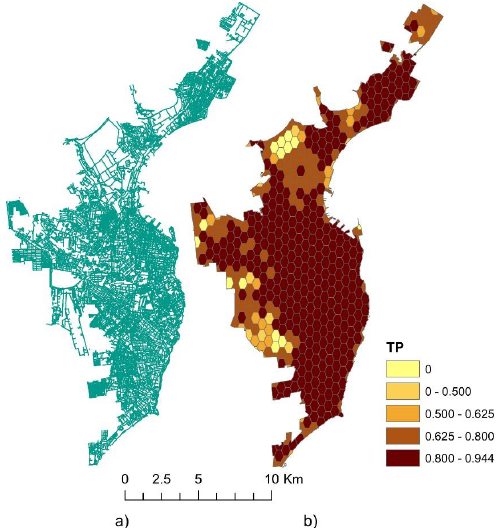
Figure 11. Modeling results for the territory of the city of Odessa, showing ( a ) the transport network and ( b ) the transport development level.